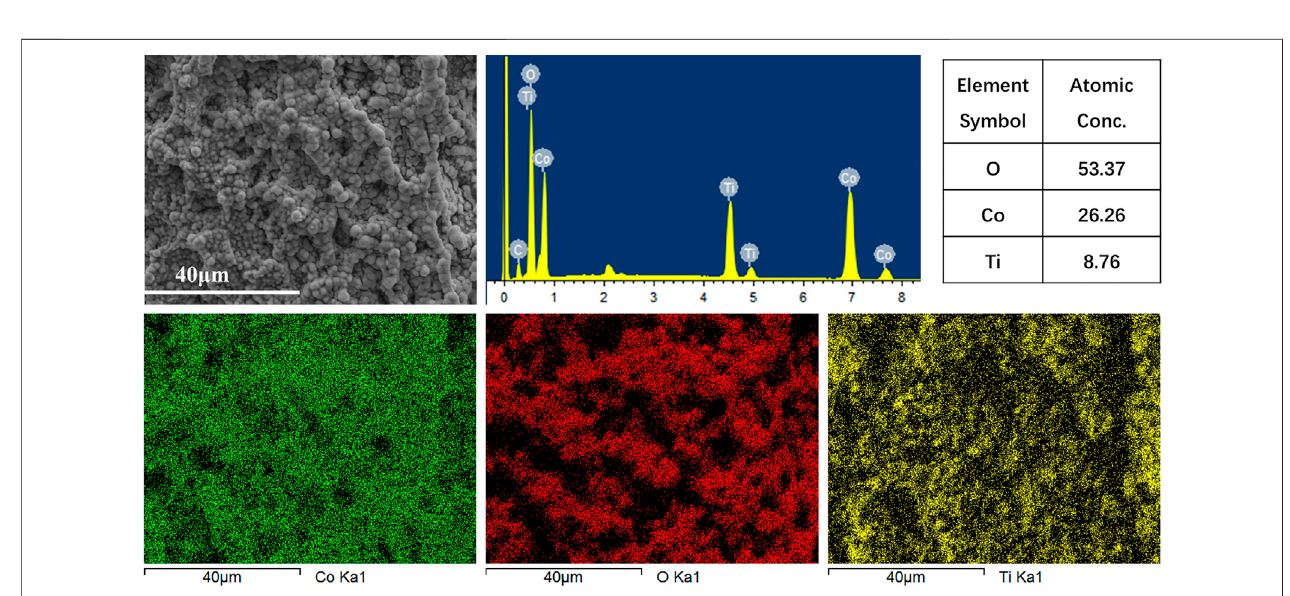
FIGURE 3 | EDS elemental analysis of the surface of Co 3 O 4 /Ti